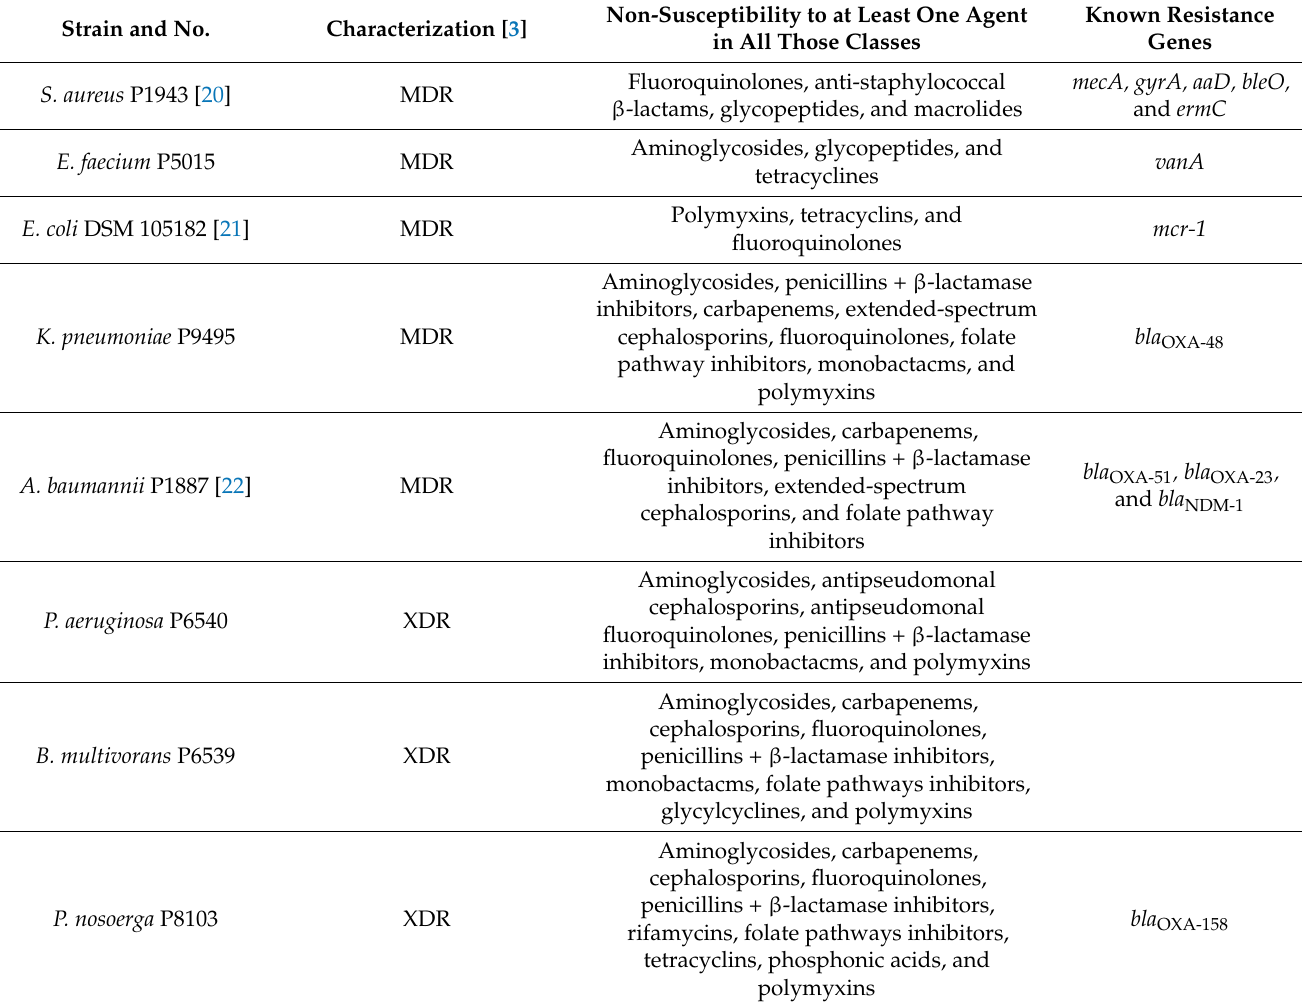
Table 1. Antimicrobial susceptibility profiles and characterization from the selected panel according to the study of Magiorakos et al. [3]. MDR: multidrug-resistant; XDR: extensively drug-resistant. Strain and